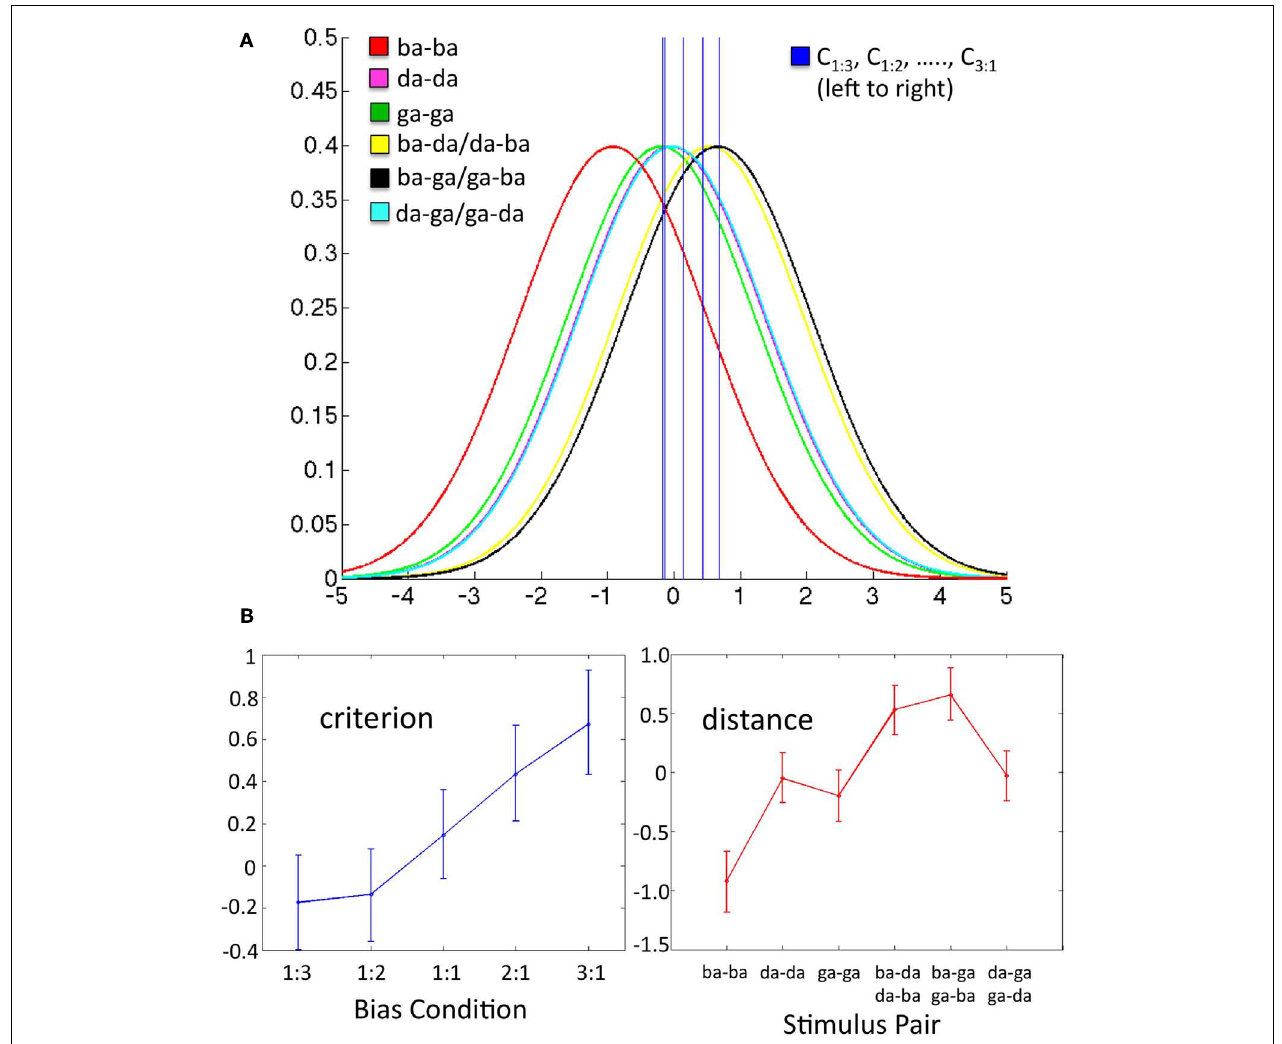
response, while values that fall below (left of) the criterion yield a “same” response.The positions of the six stimulus pair distributions remain fixed across conditions. Note that the magenta (da-da) and teal (da-ga/ga-da) distributions fall roughly on top of one another, as do the criteria for the 1:3 and 1:2 bias ratio conditions. (B) Model estimates (over all q = proportion of different trials, k = stimulus pair) for C q (criterion, left) and μ k (distance, right) plotted as line graphs with the Bayesian 95% credible intervals plotted as error bars.These values reflect the five criterion lines and the means of the six stimulus pair distributions plotted in (A) above, respectively.